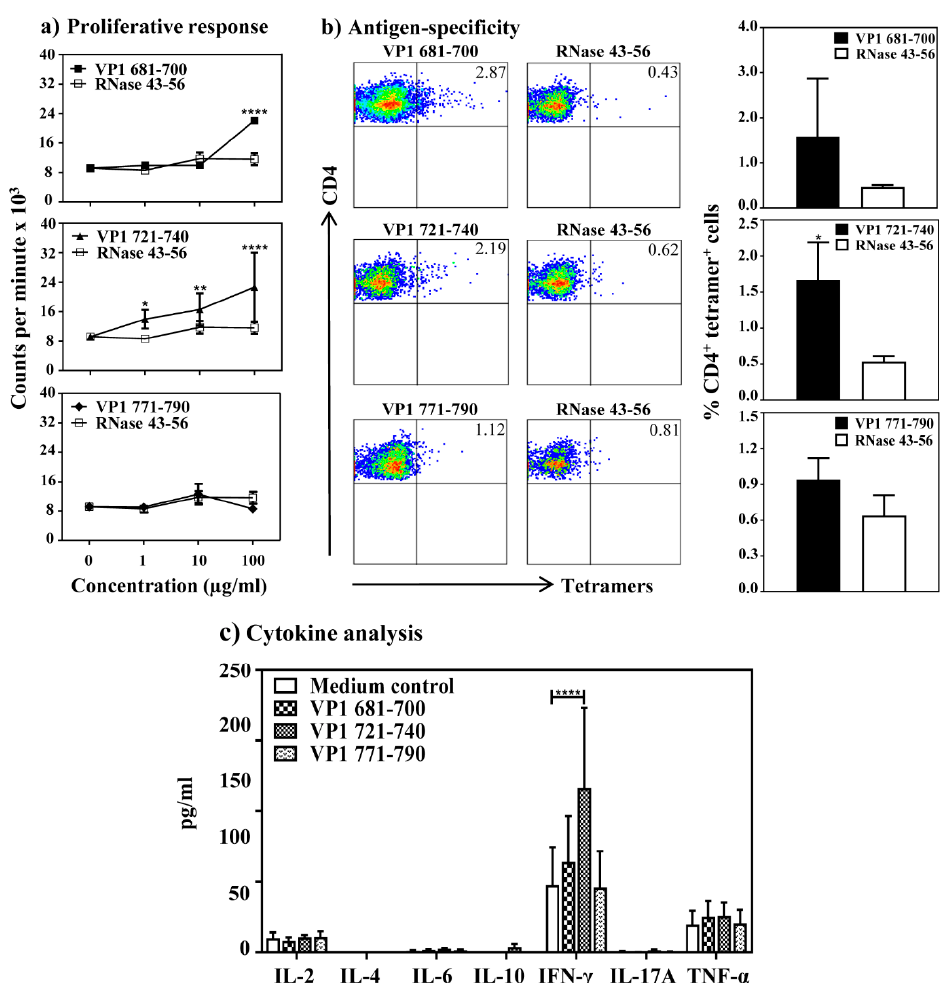
Figure 6. Evaluation of antigen-specific T cell responses in CVB4 infected mice: ( a ) Proliferative response. A/J mice were infected with CVB4, and at termination, splenocytes were stimulated with or without VP1 681–700, VP1 721–740 and VP1 771–790 or control (RNase 43–56) for 2 days, and after pulsing with 3 [H] thymidine for 16 h, proliferative responses were measured as cpm. Representative data set obtained from two individual experiments each involving four to eight mice are shown. ( b ) Antigen-specificity. Splenocytes from CVB4-infected mice were stimulated with indicated peptides and maintained in medium containing IL-2 for a week. Cells harvested between days 7–10 post-stimulation were stained with the indicated IA k / tetramers, anti-CD4 and 7-AAD. After acquiring the cells by flow cytometry, tetramer positive cells were analyzed in the live (7-AAD¯) CD4 subset using FlowJo software. Representative flow cytometric dot-plots for specific and control tetramers are shown in the left panel. Data sets obtained from three individual experiments, each involving four to eight mice are indicated in the right panel for each tetramer reagent. RNase 43–56, control. ( c ) Cytokine analysis. Splenocytes from the CVB4-infected mice were stimulated with or without the indicated peptides. Supernatants were collected on day 3 post-stimulation and were analyzed for cytokines by cytokine bead array. Data from three individual experiments each involving four to eight mice are shown. * p ≤ 0.05, ** p ≤ 0.01, and **** p ≤